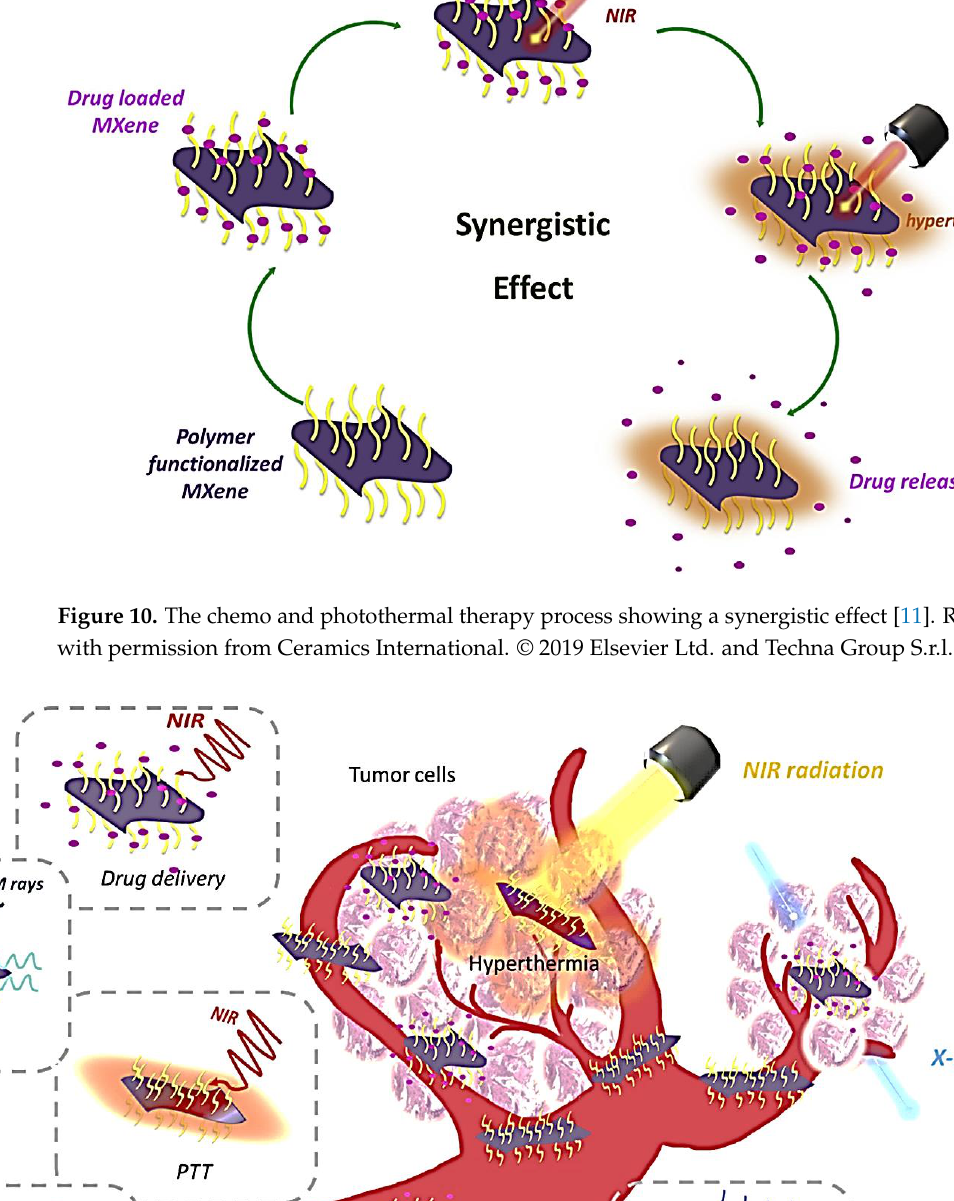
Figure 9. Polyelectrolyte/MXene Multilayers detector of human respiration (Reprinted with permis- sion from Reference [141]. Copyright 2017 American Chemical Society).